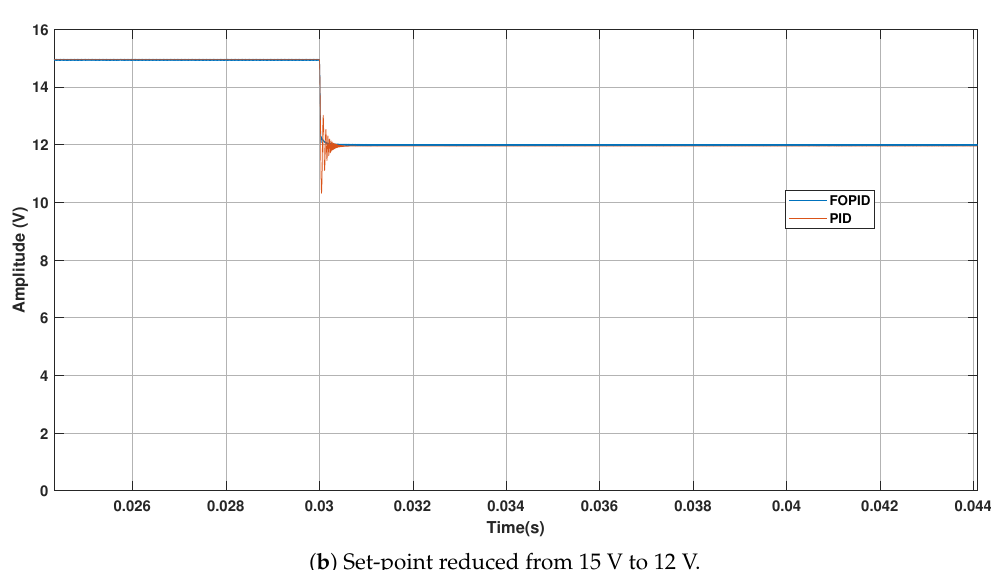
( a ) Set-point varied from 15 V to 16 V.